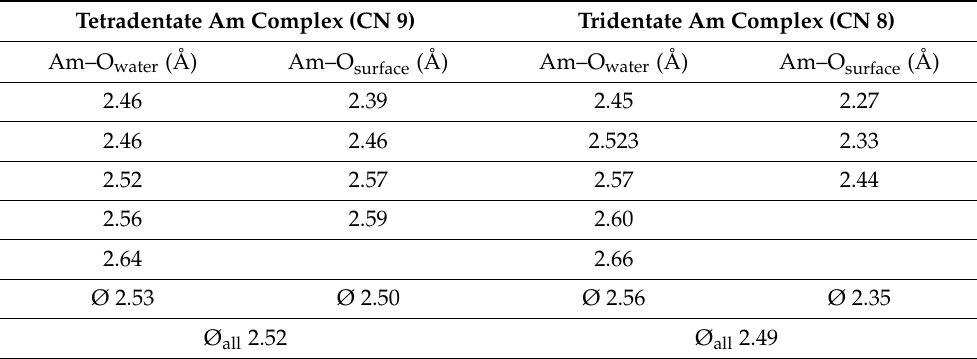
Table 2. Computed Am–O bond lengths for the tetradentate (low surface coverage) and tridentate (high surface coverage) surface complexes. Am–O water : Bond length to coordinating water oxygens. Am–O surface : Bond length to corundum (110) surface